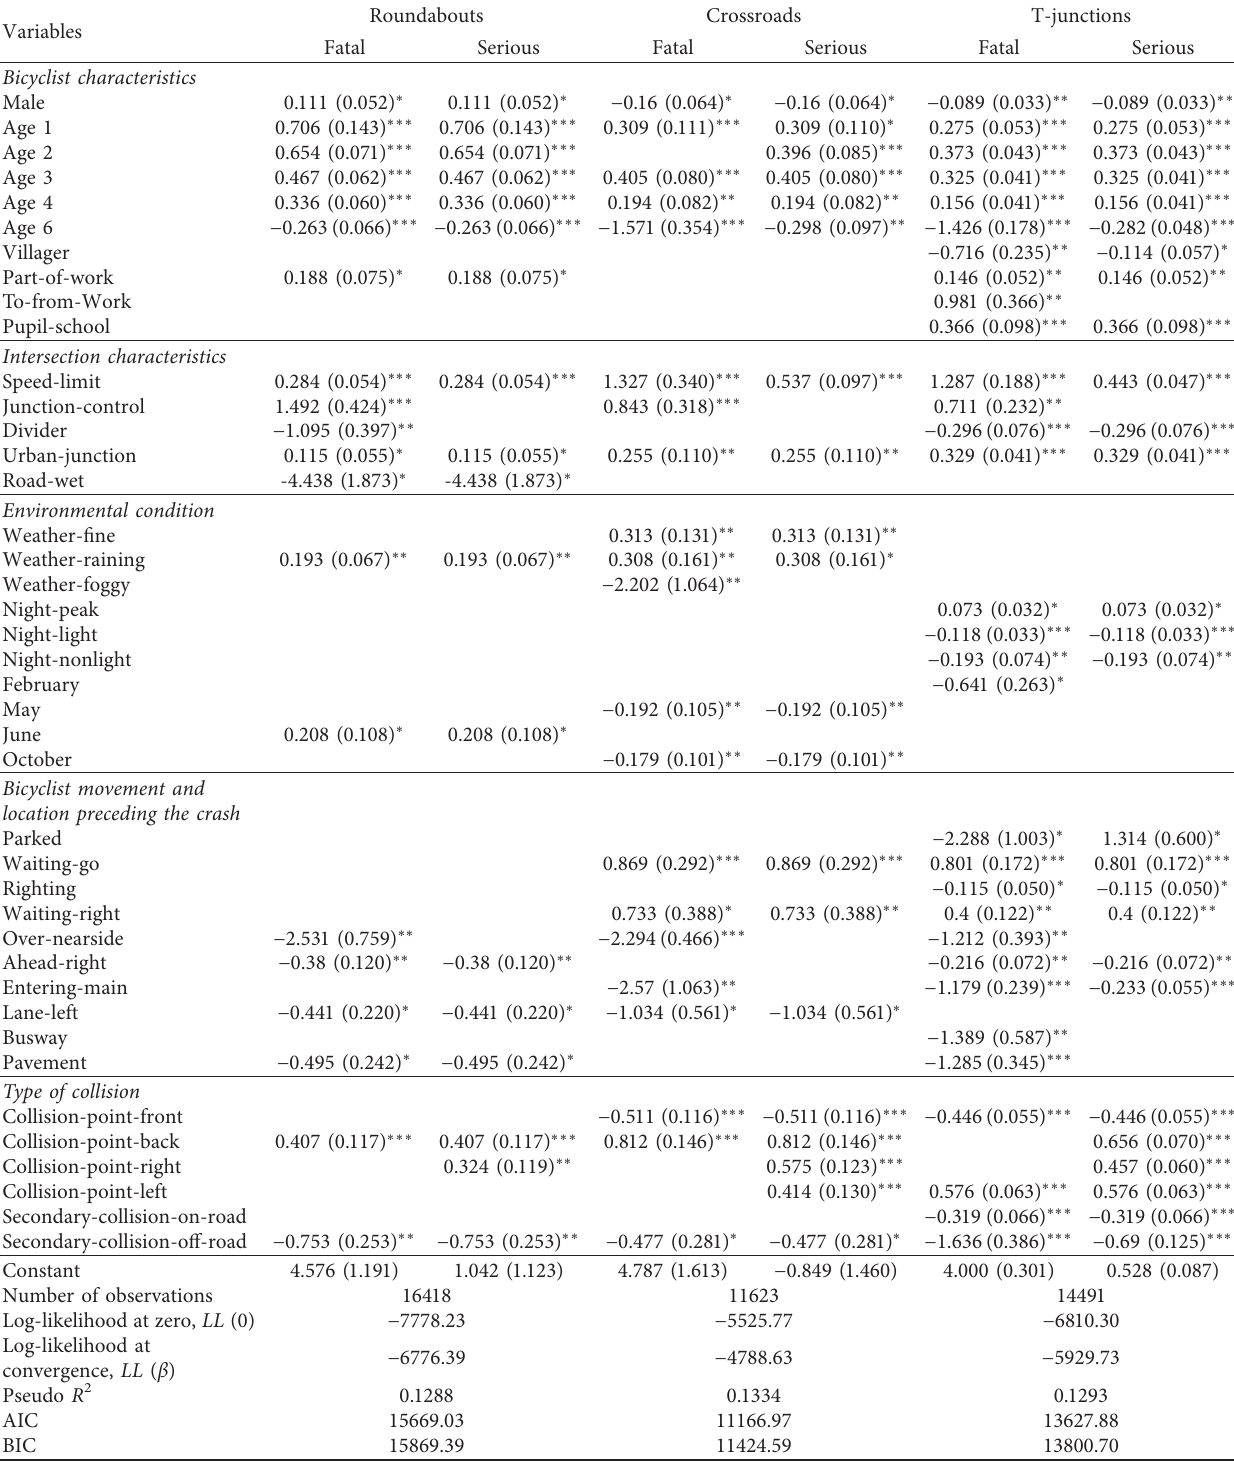
Table 4: Estimation results of the PPO